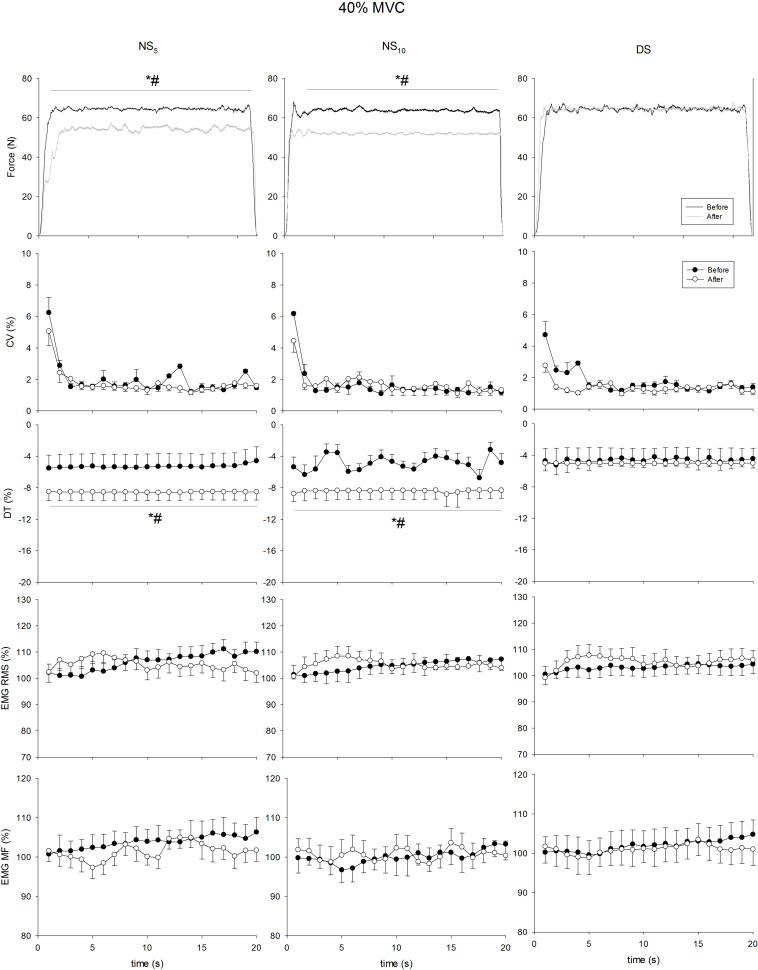
Coefficient of variation (CV), distance to target (DT), surface electromyogram root mean square (sEMG RMS), and mean frequency (sEMG MF) at 40% of maximum voluntary contraction (MVC) force maintained for 20 s at the beginning (pre, solid circle) and at the end (post, blank circle) of the shift cycle in the three groups. NS5, 5-day night shift; NS10, 10-day night shift; DS, day/swing shift. *p < 0.05 post vs. pre; #p < 0.05 NS5 or NS10 vs. DS.